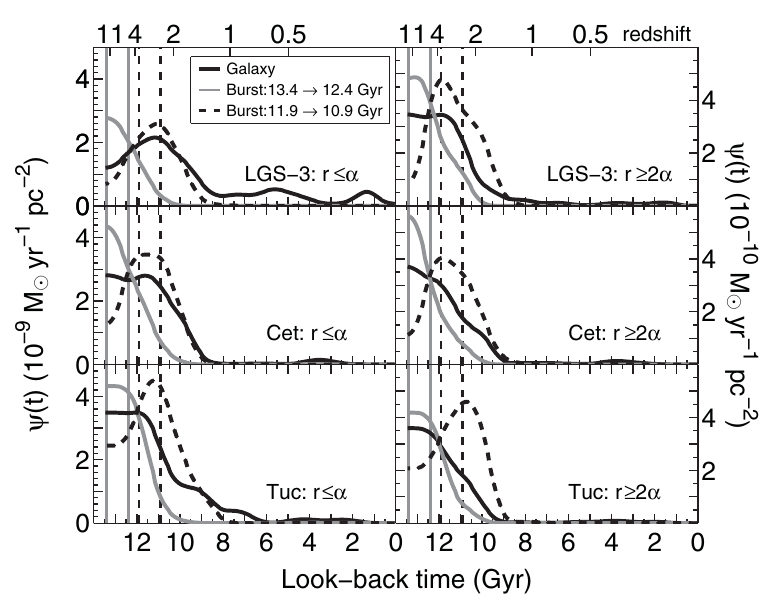
Figure 3. The effect of UV-background in the SFH of two regions ( r ≤ (cid:1) and r ≥ 2 (cid:1) ) of LGS-3, Cetus, and Tucana. Two input mock star bursts and their recovered SFHs located before (gray, solid line) and after (black, dashed line) the EoR are shown. The resolved SFH of each galaxy is shown with a solid, black